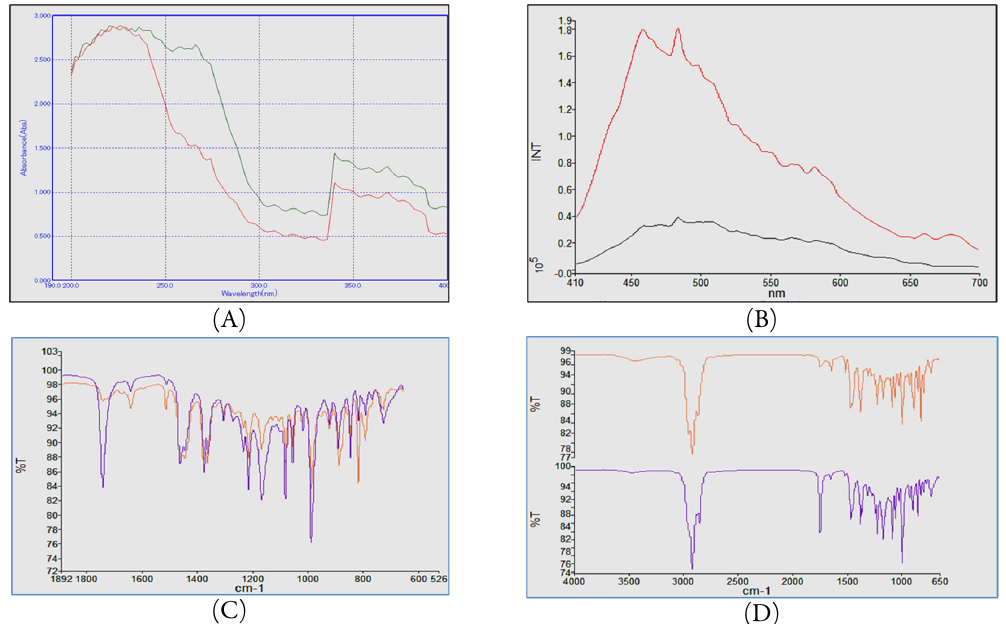
Figure 3. UV (A), Fluorescent (B) and FT-IR analysis (C: superimposed; D: split form) of light (IDHBH) and dark oil